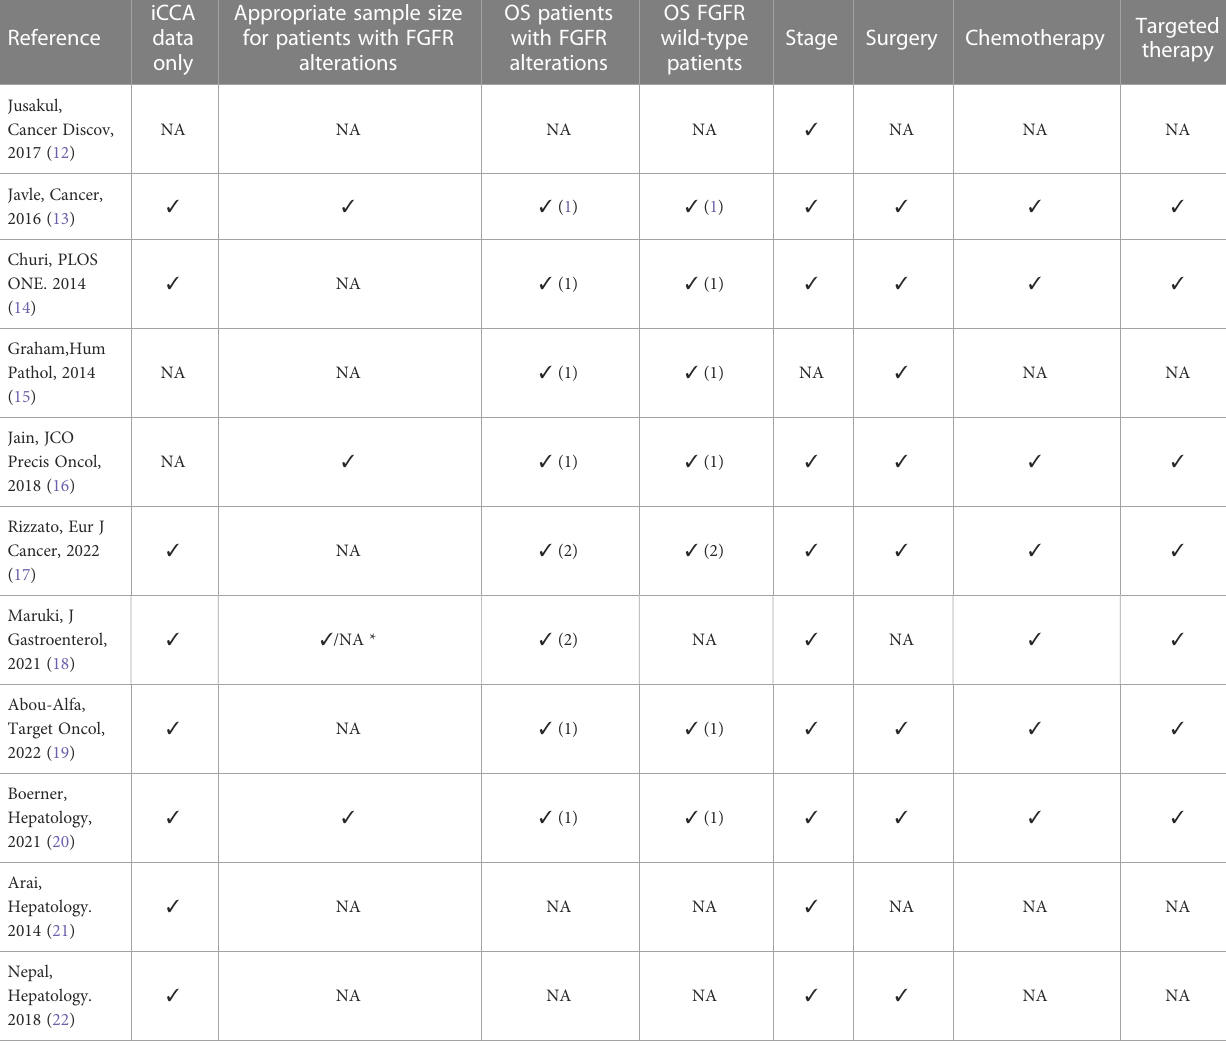
TABLE 3 Trial ’ s bias/shortcoming, if relevant data are provided, a checkmark sign is used ( ✓ ), otherwise a (NA) standing for Not Available is used.